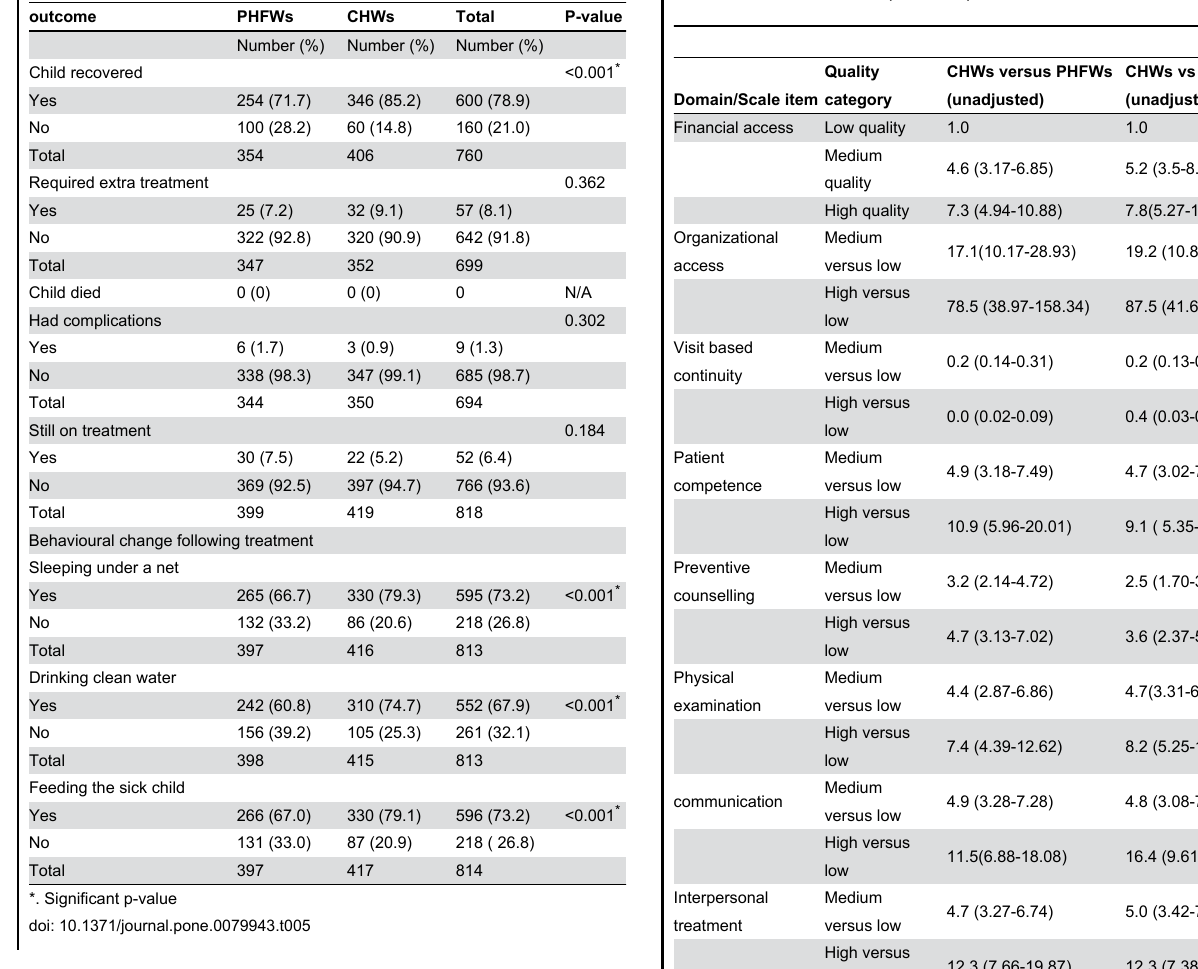
Table 6. Multinomial logistic regression model of association between categorised perceived quality of care and service provider for the overall perceived quality score and for each domain (N=